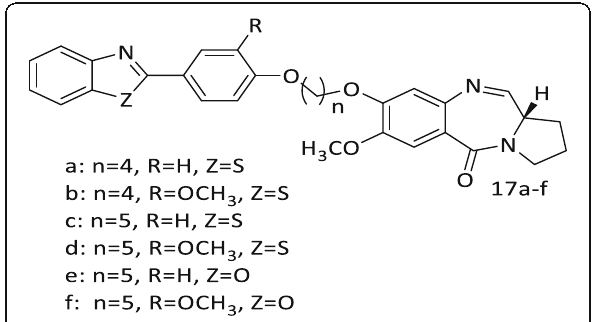
Fig. 51 Pyrrolobenzodiazepine-benzoxazole/benzothiazole